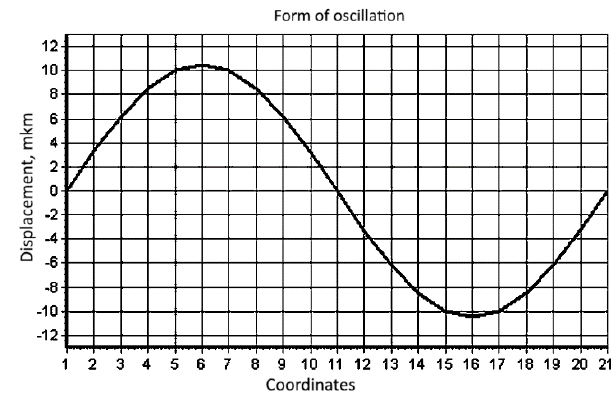
Fig. 6. The shape of the rod oscillations with fixed